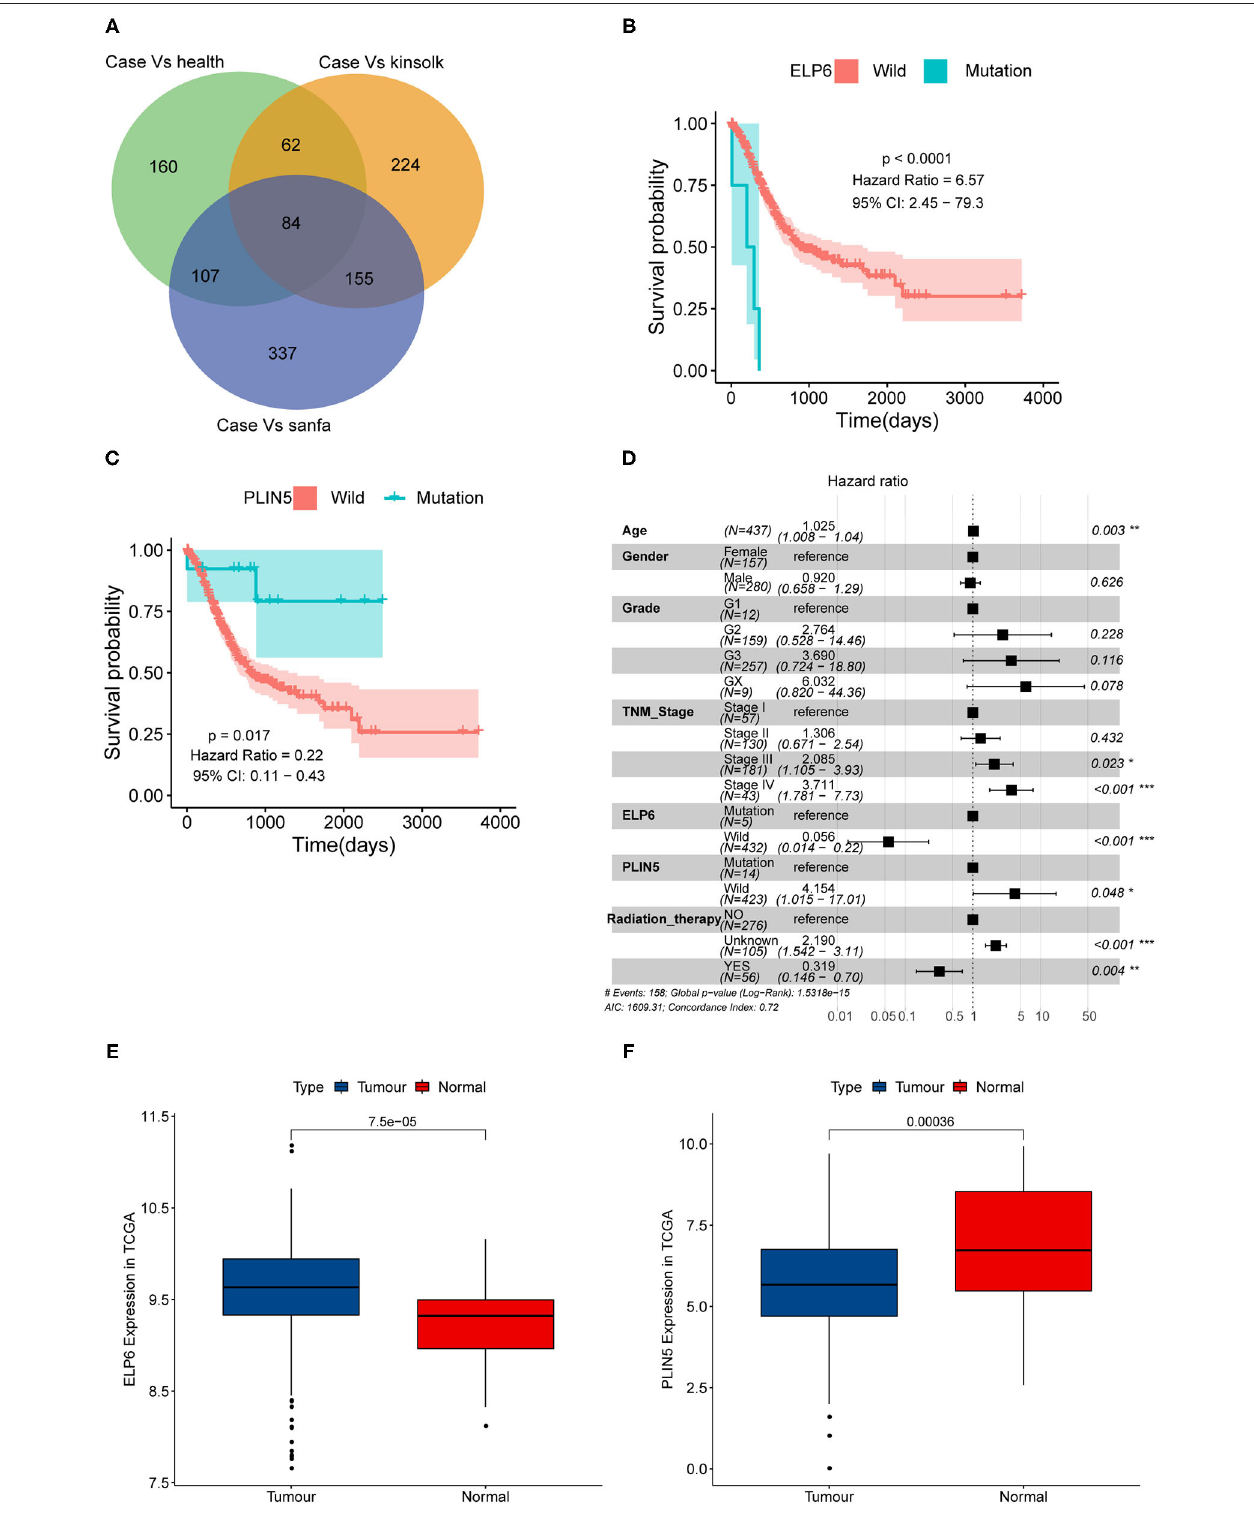
FIGURE 1 | ELP6 and PLIN5 mutations were related to the prognosis of patients with GC. (A) Venn diagram of screening candidate mutated genes. (B) KM survival curve showed that ELP6 mutation was a poor prognostic indicator. (C) PLIN5 mutation was a good prognostic indicator for patients with GC. (D) Multivariate Cox regression analysis results. Hazard ratio (HR) > 1, samples have a higher risk of death; and HR < 1, samples have a lower death risk. (E,F) The expression of ELP6 and PLIN5 in GC samples and adjacent samples, respectively. GC, gastric cancer; KM, Kaplan–Meier. * p -value < 0.05; ** p -value < 0.01; *** p-value < 0.001.